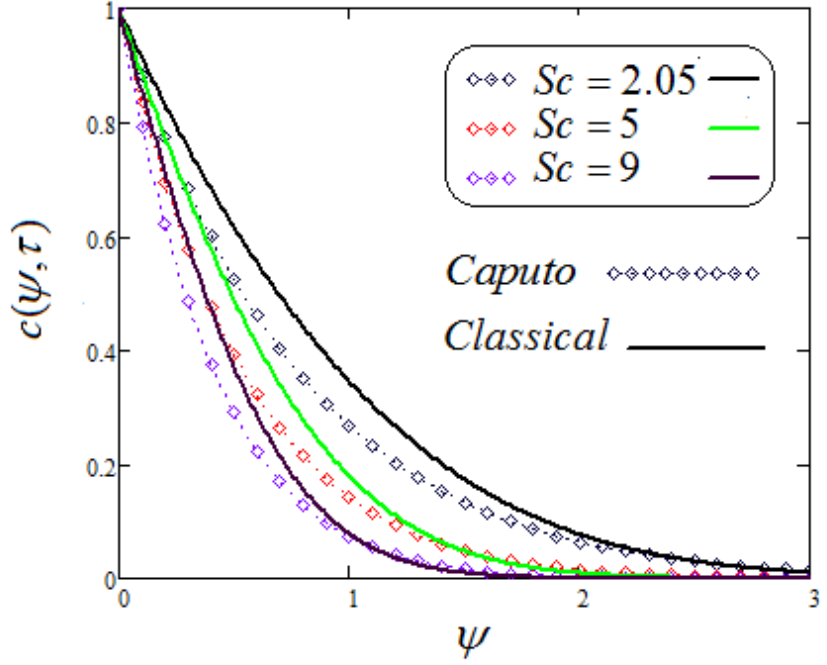
Figure 10. Trace of concentration comparison for dissimilar values of Sc